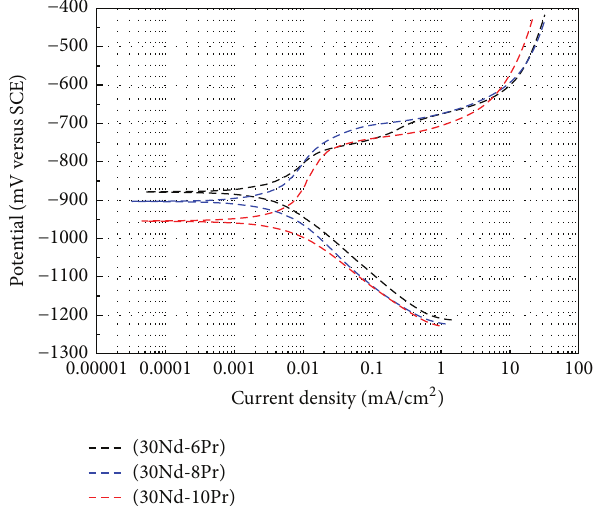
Figure 3: Variation of 𝐸 corr for Nd magnets tested in 3.5% NaCl solution at 25 ∘ C for 24